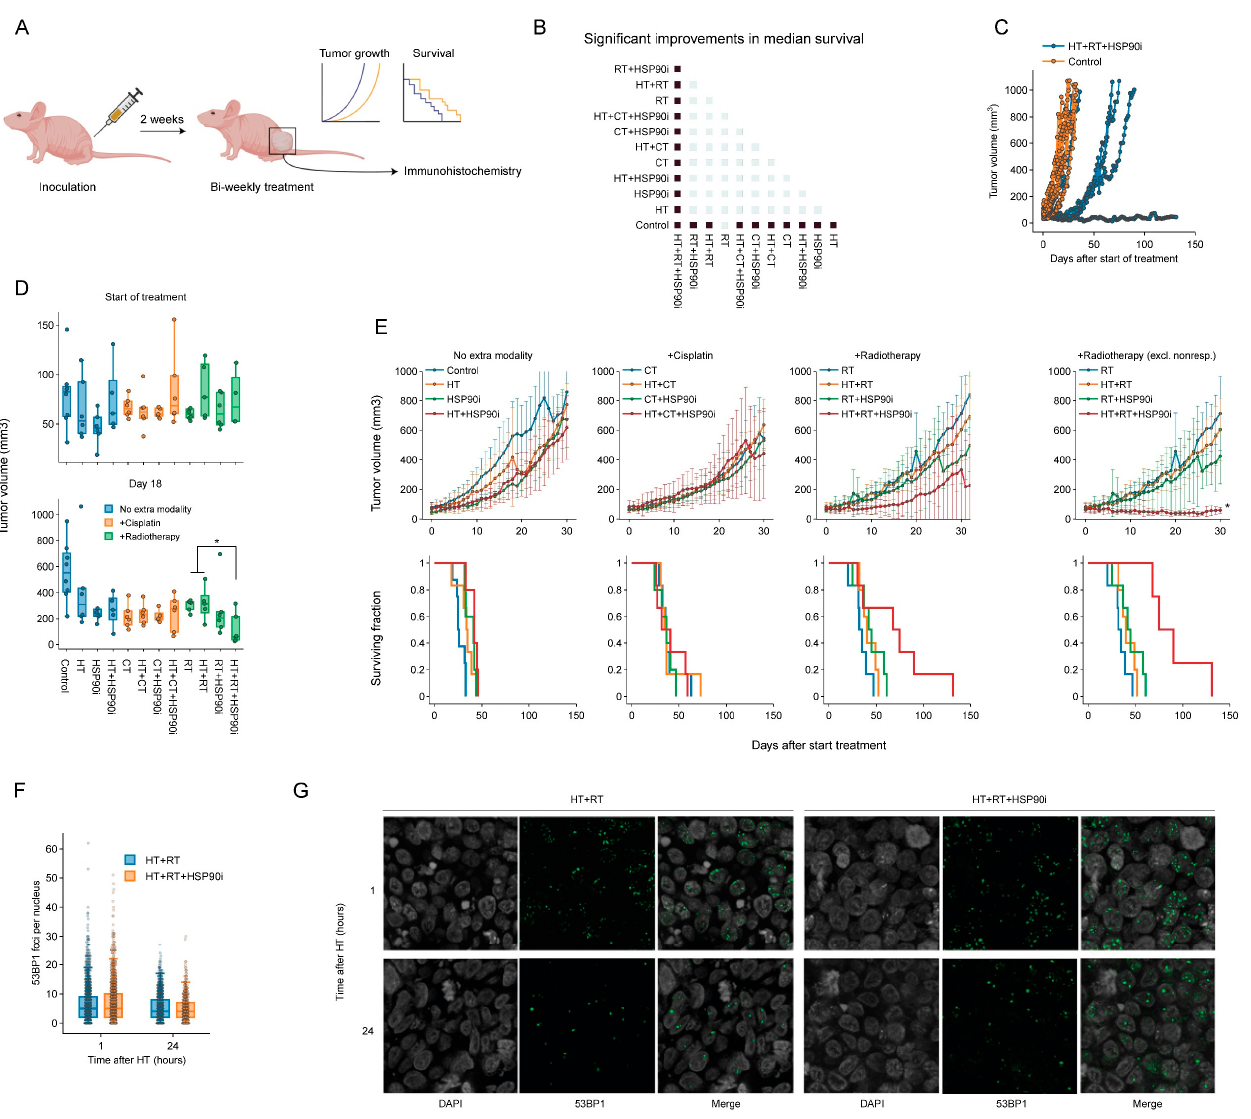
Figure 6. Ganetespib improves radio-thermotherapy in a cervix cancer mouse model. ( A ) Experimental setup. Hind paws of nude mice were inoculated with SiHa cells and animals were followed until the resulting tumors reached approximately 50 mm 3 . The animals were then treated with combinations of hyperthermia (HT), radiotherapy (RT), cisplatin (CT), and ganetespib (HSP90i) twice a week. Tumor growth was monitored, and mice were sacrificed when the volume reached 1000 mm 3 . A subgroup of mice was treated once and sacrificed to allow monitoring of DNA double-strand break induction and repair. ( B ) Heatmap showing significant (fold) improvements (marked in dark blue) in median survival. ( C ) Tumor volume of untreated cohort versus the cohort treated with HT+RT+HSP90i, showing non-responders in the latter. ( D ) Tumor volume per condition at the start of the treatment schedule and on day 18. ( E ) Tumor volume (top) and Kaplan–Meier analysis (bottom). For the RT arm, results are shown with inclusion and exclusion of non-responders. Noteworthy significant differences are marked with an asterisk. ( F ) Boxplot showing the number of 53BP1 foci per cell 1 h and 24 h after treatment. ( G ) Representative images used for the quantification shown in F. Scale bar: 10 μ M.